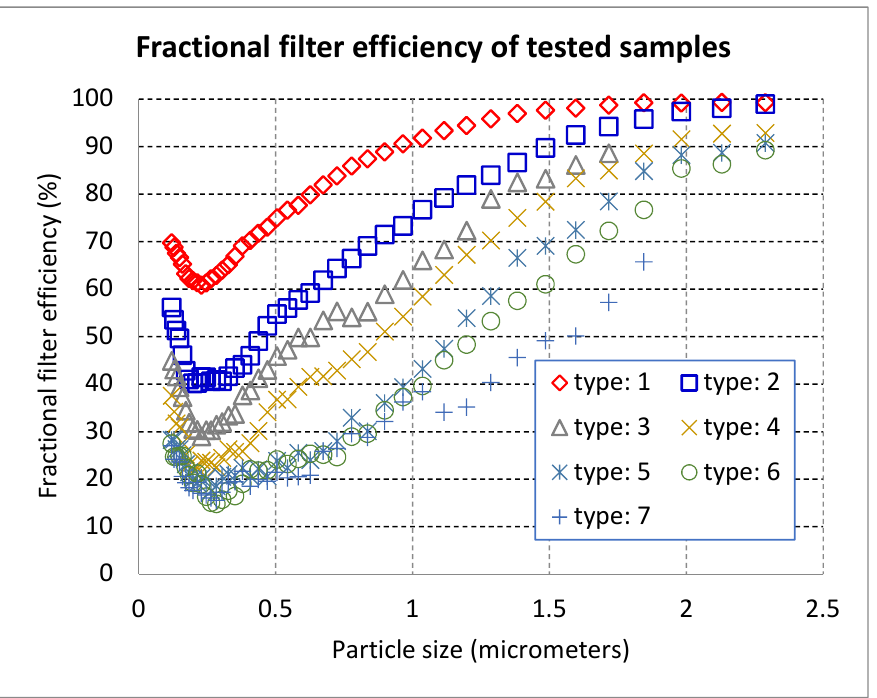
Figure 5. Fractional filter efficiency of samples.